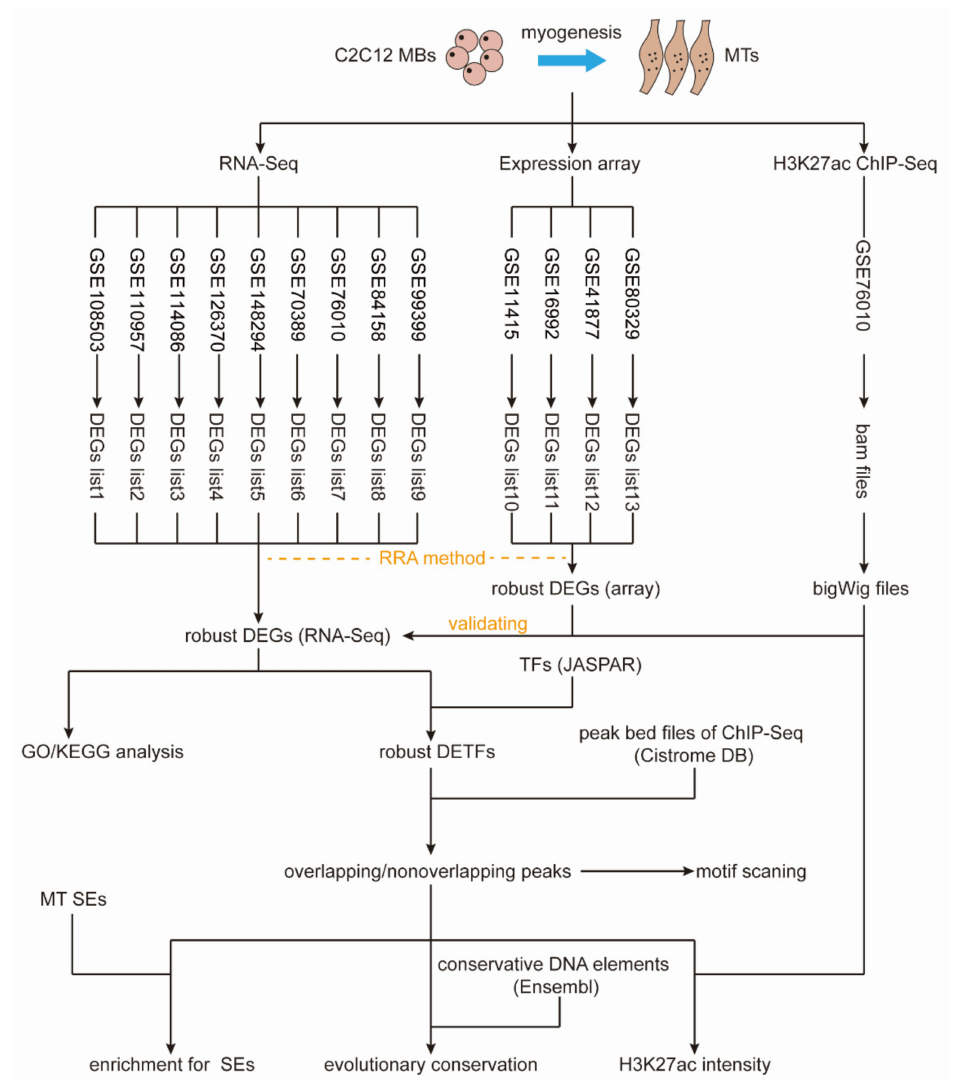
Figure 1. Study roadmap. Data processing and DEG identification were performed on 9 RNA-Seq datasets and 4 expression array datasets from C2C12 MBs and MTs, respectively. Nine DEG lists from RNA-Seq data and 4 DEG lists from array data were then integrated using the RRA method to obtain robust DEGs. In addition, the H3K27ac ChIP-Seq dataset was processed to obtain bigWig files representing the H3K27ac intensity in MBs and MTs. The accuracy of robust DEGs (RNA-Seq) was validated with robust DEGs (array) and H3K27ac intensity. If not specified, robust DEGs represent robust DEGs (RNA-Seq). Next, enrichment analysis for Gene Ontology (GO)/Kyoto Encyclopedia of Genes and Genomes (KEGG) terms was performed on robust DEGs. The list of vertebrate TFs was downloaded from the JASPAR database and intersected with the robust DEGs to obtain robust DETFs. The peak bed files of TF ChIP-Seq data were downloaded from the Cistrome Data Browser (DB), which were then processed to investigate the cooperative binding of robust DETFs. Finally, the motifs of overlapping and nonoverlapping target peaks are scanned, and the ability of these peaks to enrich H3K27ac signals, SEs, and conservative DNA elements was